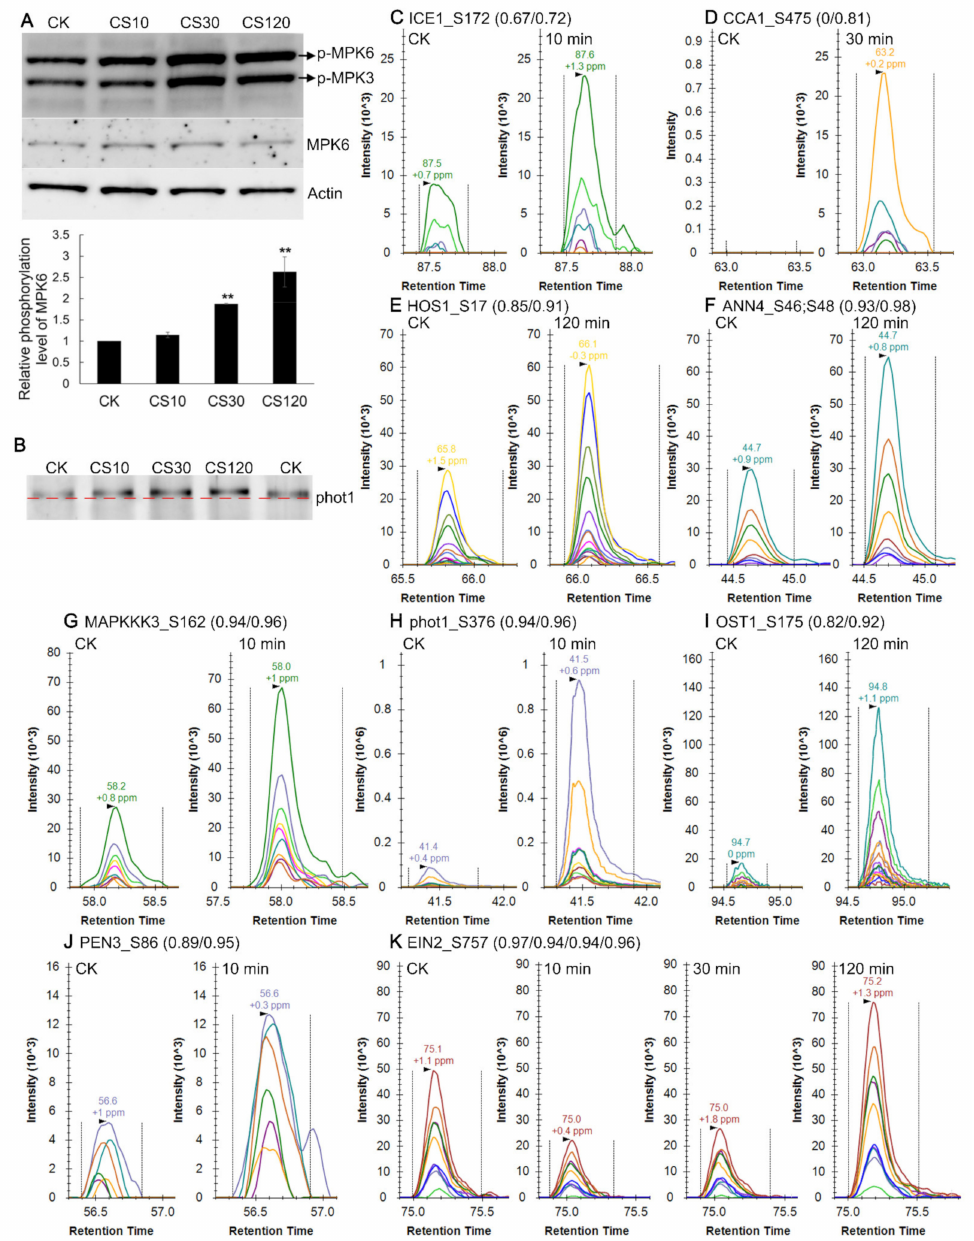
Figure 5. Validation of protein phosphorylation alteration upon cold stimuli by Western blot ( A , B ) and targeted mass spectrometry analysis ( C – K ). ( A , B ) Arabidopsis seedlings were cold treated for 10, 30, and 120 min. Total proteins of seedling samples were immunoblotted using anti-pTEpY, anti-MPK6, anti-Actin and anti-phot1, respectively, the histogram shows the relative phosphorylation level of MPK6 (normalized to total MPK6 protein abundance). ( C – K ) Representative extracted ion chromatograms (n > 5 co-eluting fragments) are shown for cold-modified p-sites for ( C ) ICE1:S172, ( D ) CCA1:S475, ( E ) HOS1:S17; ( F )ANN4:S46/S48; ( G )MAPKKK3:S162; ( H ) phot1:S376; ( I ) OST1:S175; ( J ) PEN3:S86; ( K ) EIN2:S757. The peak correlation to the library spectra (dotp) is indicated in parentheses after the p-sites of each protein. Three or four biological repeats were performed for each PRM validation, and the p-sites assignments were manually checked. ** p <